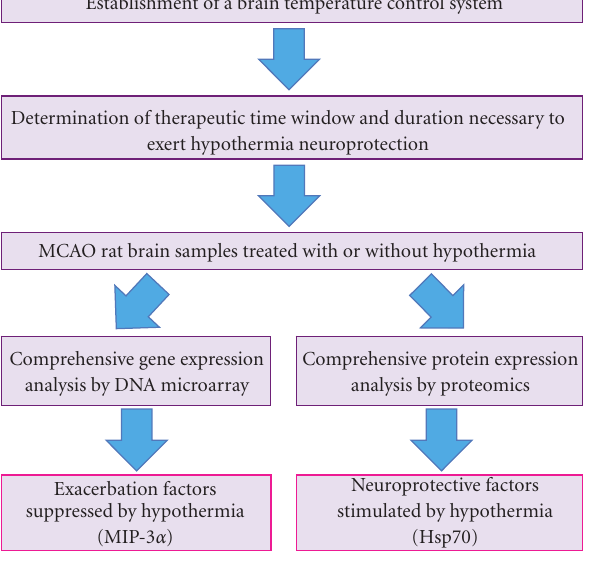
Figure 1: An experimental strategy to identify potential drug targets associated with